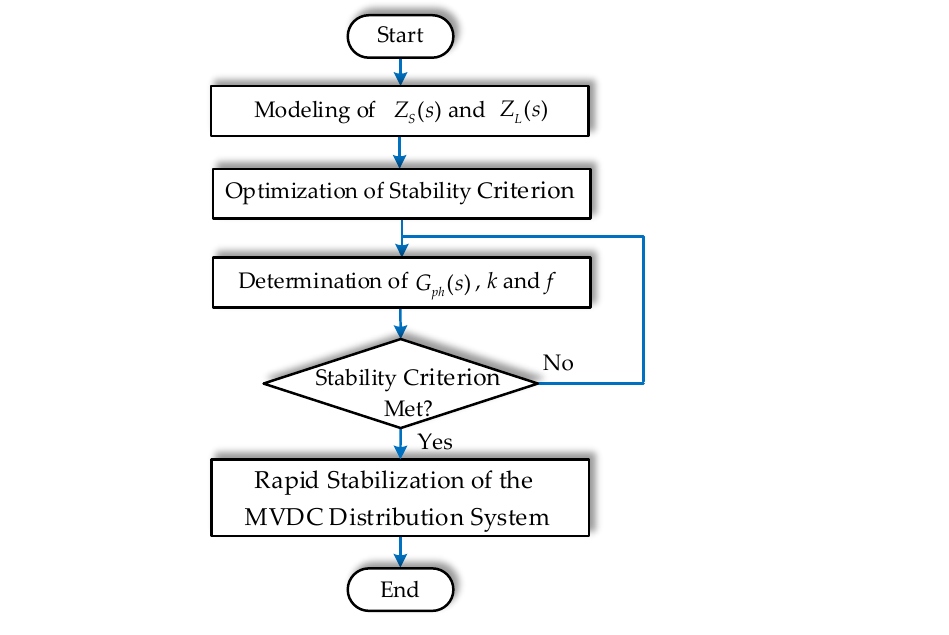
Figure 9. Flowchart of the proposed IPR method.